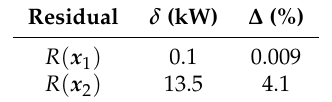
Table 3. Average absolute and percentage residuals between measurement and model estimation.